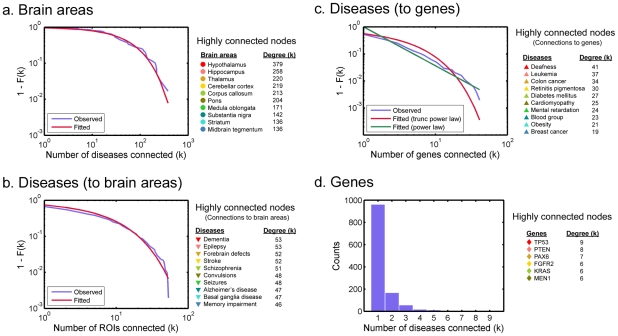
Degree distribution plots of the gene-disease-brain tripartite network.Degree distributions of brain areas (a), diseases to brain areas (b), diseases to genes (c), and genes (d) are shown. For the degree distributions for brain areas and diseases (a)–(c), the complementary cumulative distribution (1−F(k)) is plotted, whereas the actual frequencies are plotted for genes (d). Panel (d) is plotted as a bar graph since the range of degrees is limited and does not span a single order of magnitude. The best-fit exponentially truncated power law curves are also plotted for (a)–(c). In addition, the best-fit power law curve is also shown in (c). Highly connected nodes corresponding to each degree distribution are also listed, along with the markers corresponding to those nodes indicated in Figure 1.